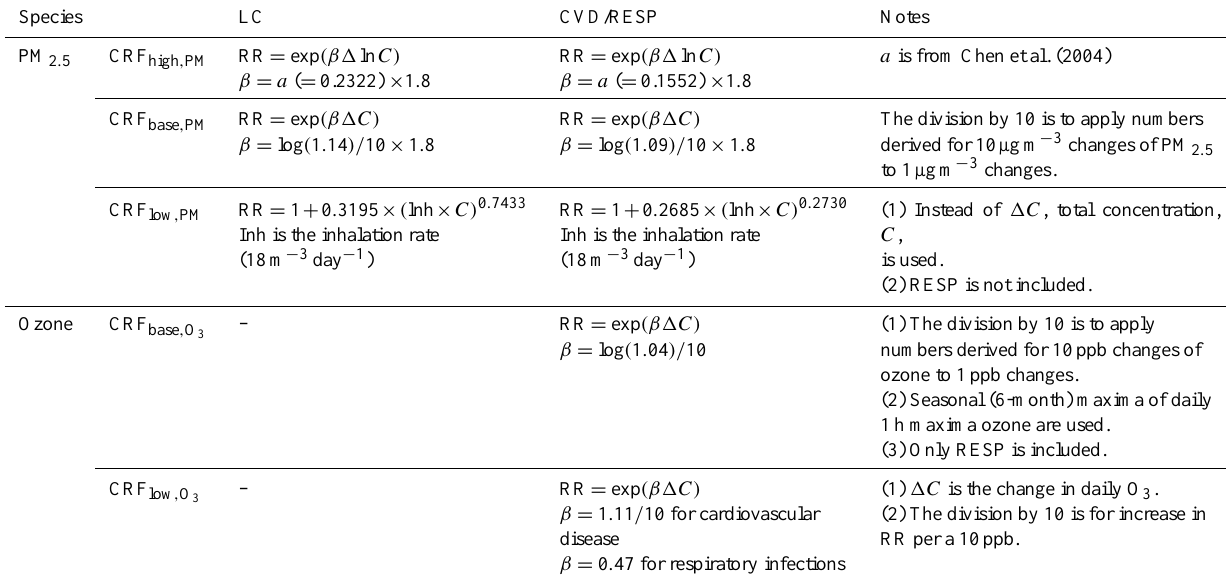
Table 2. Concentration-response functions (CRFs) used to compute mortality due to PM 2 . 5 and ozone. LC stands for lung cancer, CVD for cardiovascular disease, and RESP for respiratory disease and infections. See Sect. 3.2 for details.